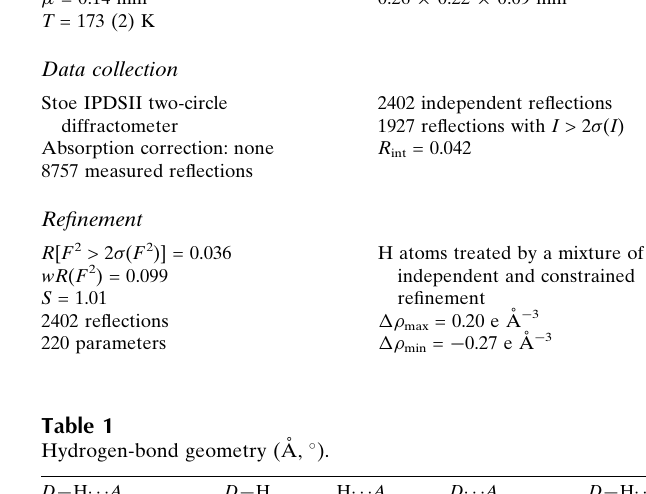
Hydrogen-bond geometry (A˚ , (cid:3)